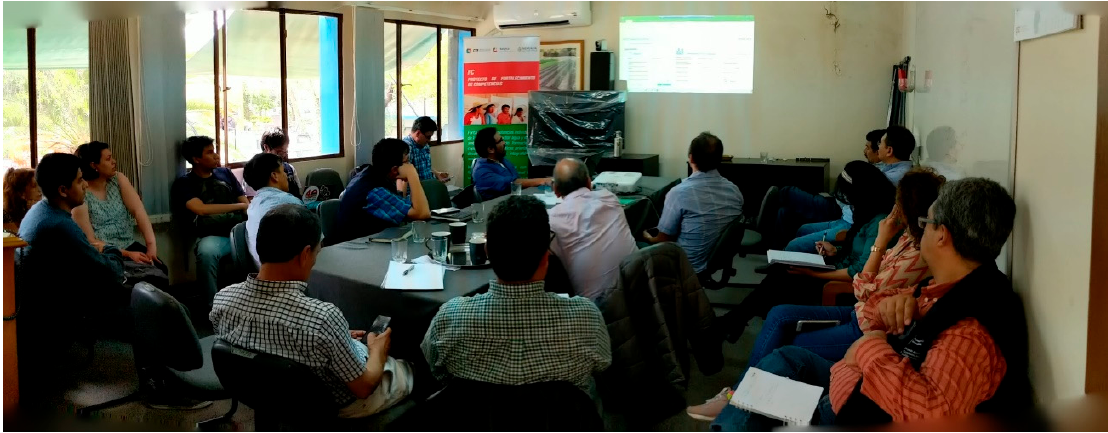
Figure 5. Photograph of the workshop for the evaluation of medium- (2025) and long-term (2040) intervention actions using the participatory decision-making model.